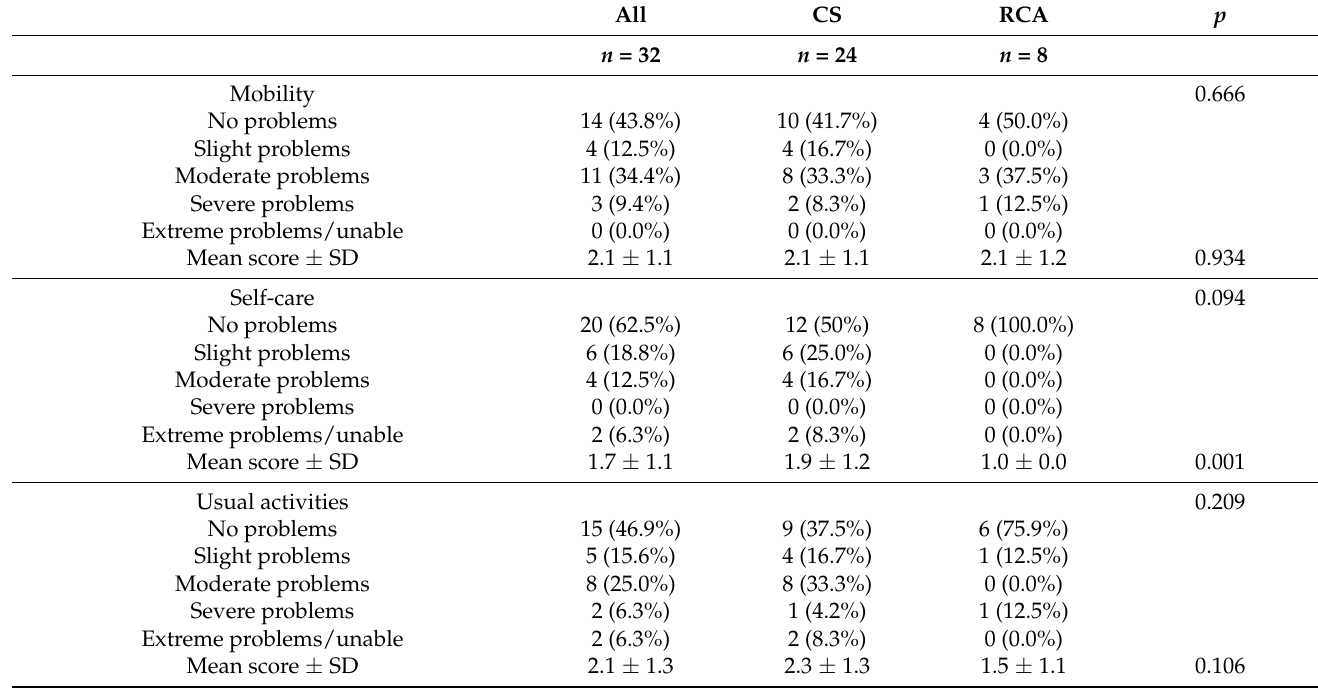
Table 2. Frequencies and proportions reported by dimension and level, EQ-VAS and EQ-5D-5L index